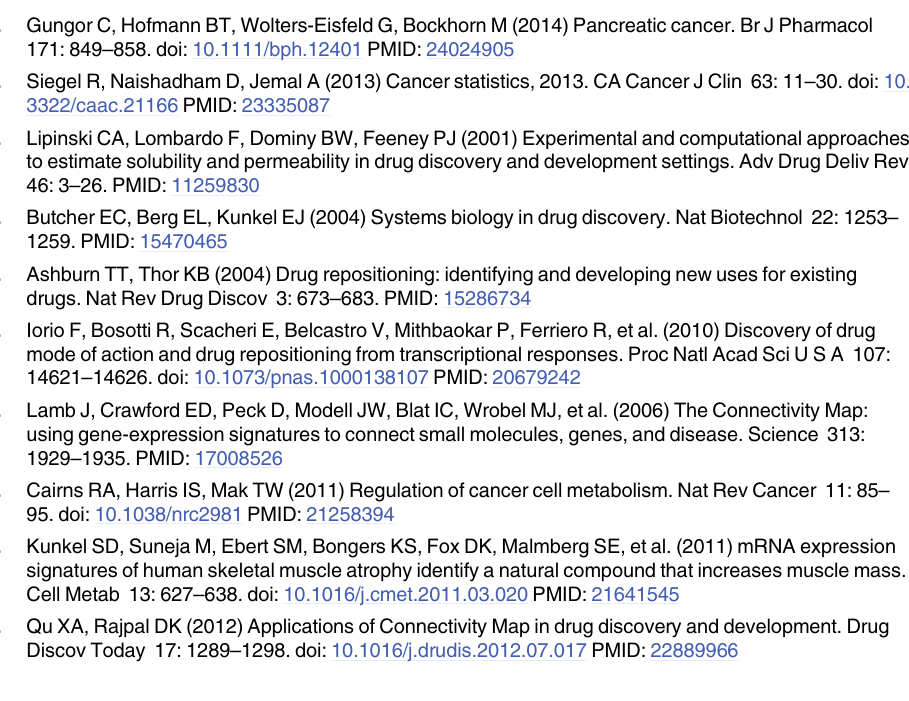
S1 Table. The predicted key enzyme-coding genes for each of the three pancreatic cancer datasets. S2 Table. The enriched pathways and biological processes for the KPC enzymes predicted in all three cancer datasets. S3 Table. MTT assay results of pancreatic cancer cell